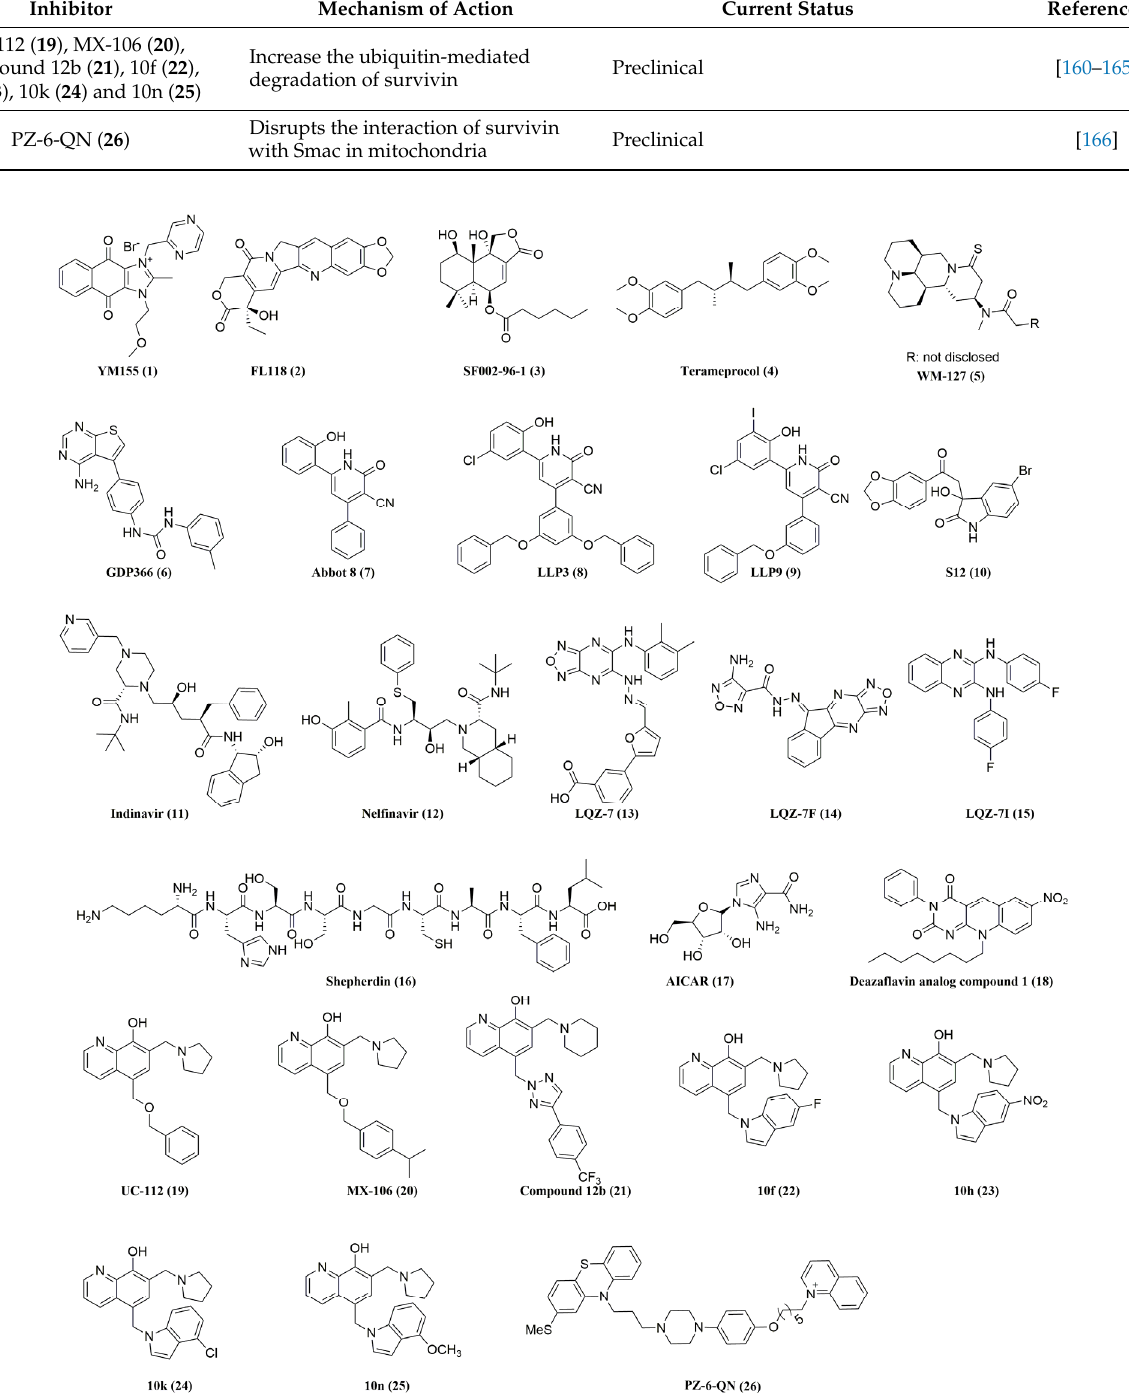
Figure 4. The chemical structures of survivin inhibitors reviewed in this article are shown. This figure was created using ChemDraw (version 21).